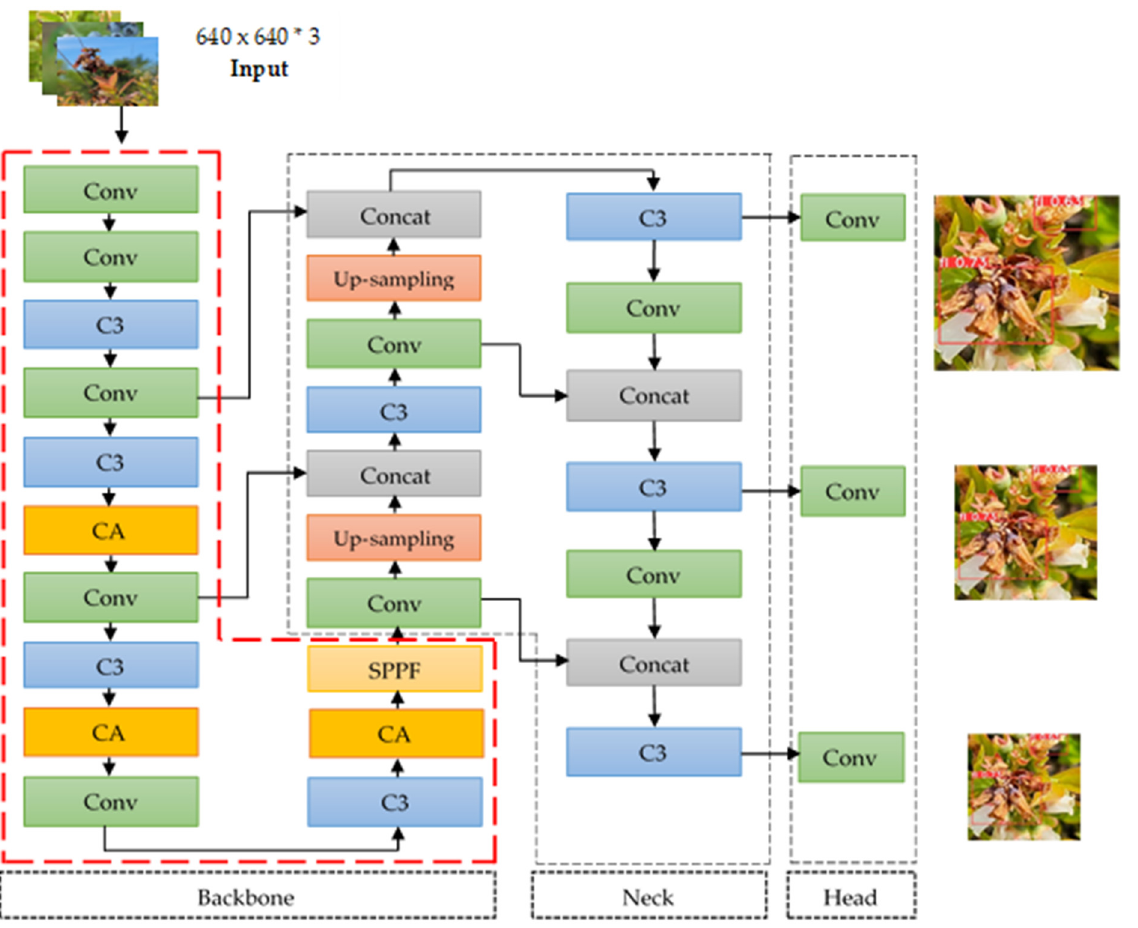
Figure 4. The improved Yolov5s-CA network model structure.